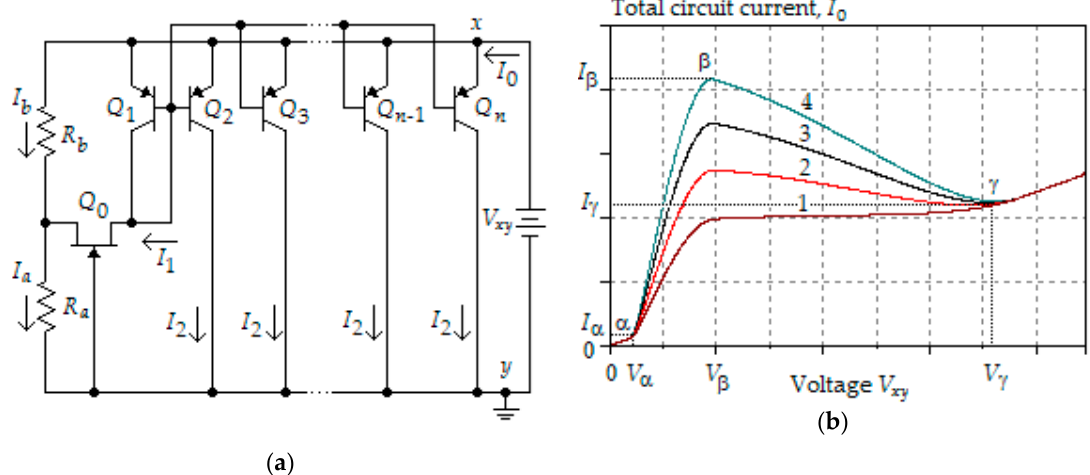
Figure 1. ( a ) Negative differential resistance circuit with multiple simple current mirror; ( b ) N-type current-voltage characteristics of the circuit.